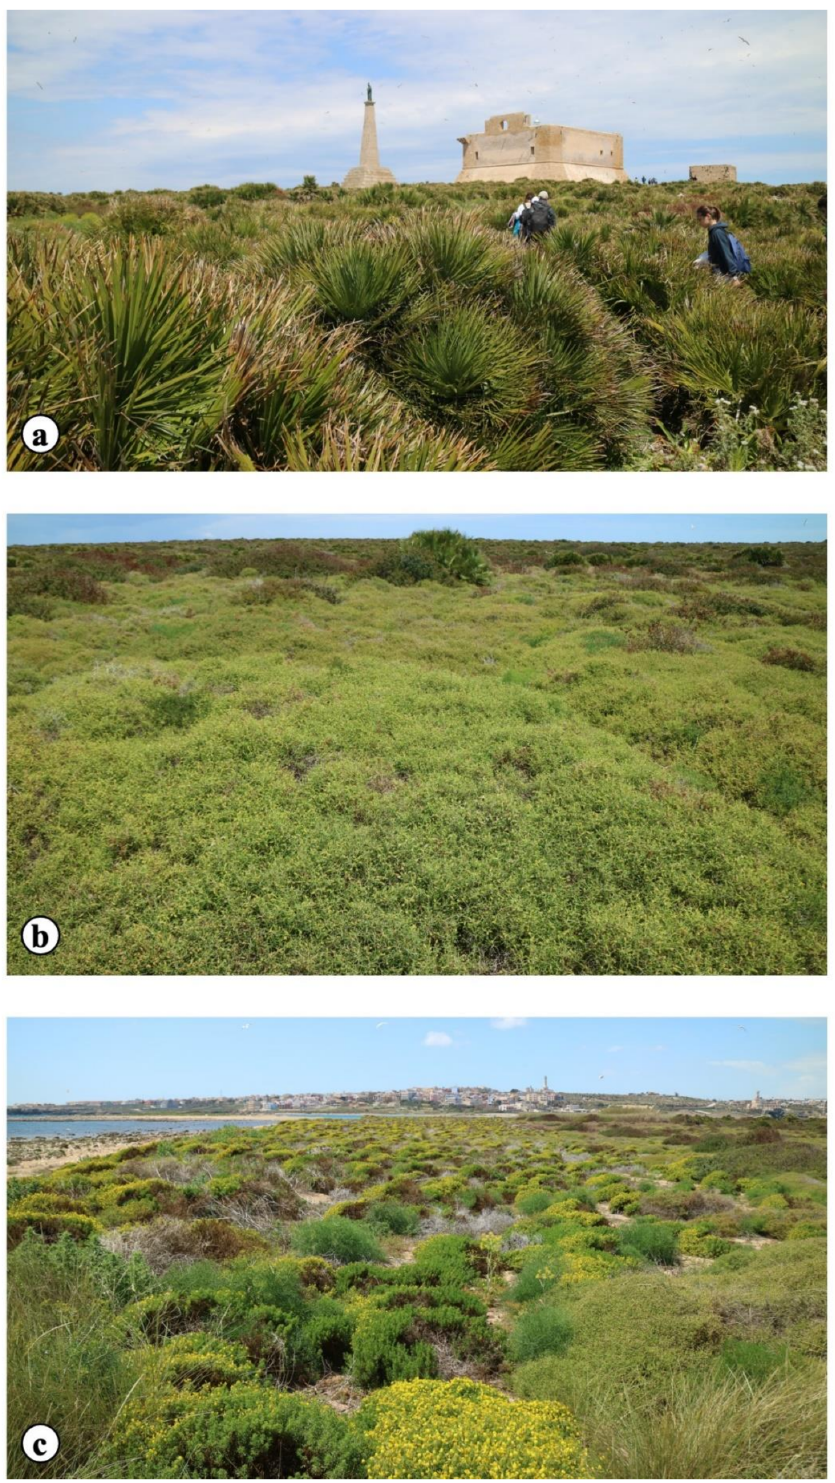
Figure A1. Photo plate illustrating different habitat types on the Island of Capo Passero: ( a ) Chamaerops humilis maquis ( Pistacio lentisci-Chamaeropetum humilis ; ( b ) Poterium spinosum garrigue ( Chamaeropo humilis-Sarcopoterietum spinosi ); ( c ) Stable dunes with Ononis ramosissima ( Centaureo sphaerocephalae-Ononidetum ramosissimae